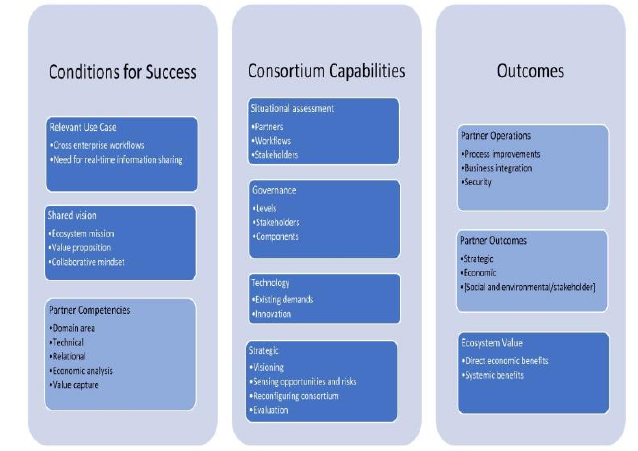
Figure 2: Consortium Capabilities